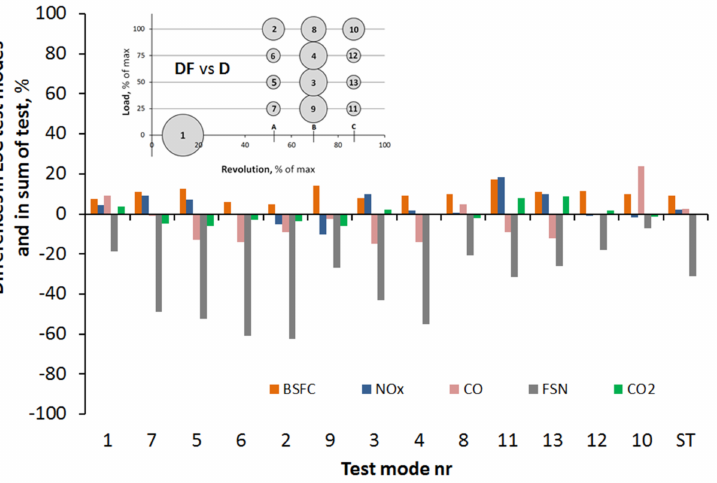
Figure 9. Differences in averages by feeding the engine with DF vs. feeding with D fuel (in percent). Clear differences, i.e., those that exceed 20%, are visible in relation to emissions of CO and FSN when engine fed DB or only in relation to FSN when the engine fed DF. At this workplace, the question arises whether the differences actually recorded are large or small and whether they are